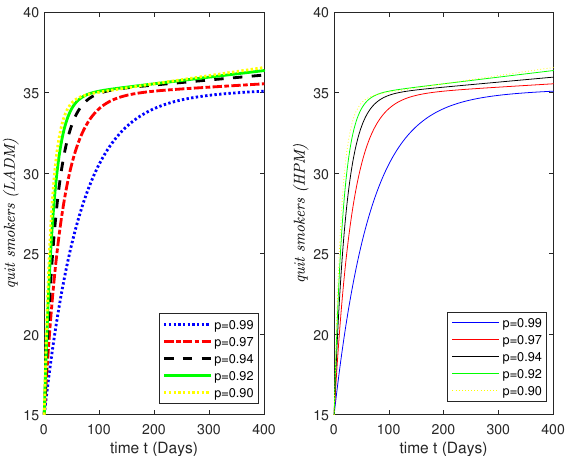
Figure 10. Comparison of the approximate solution for Y ( t ) class of the suggested model at different arbitrary fractional orders by LADM and HPM.